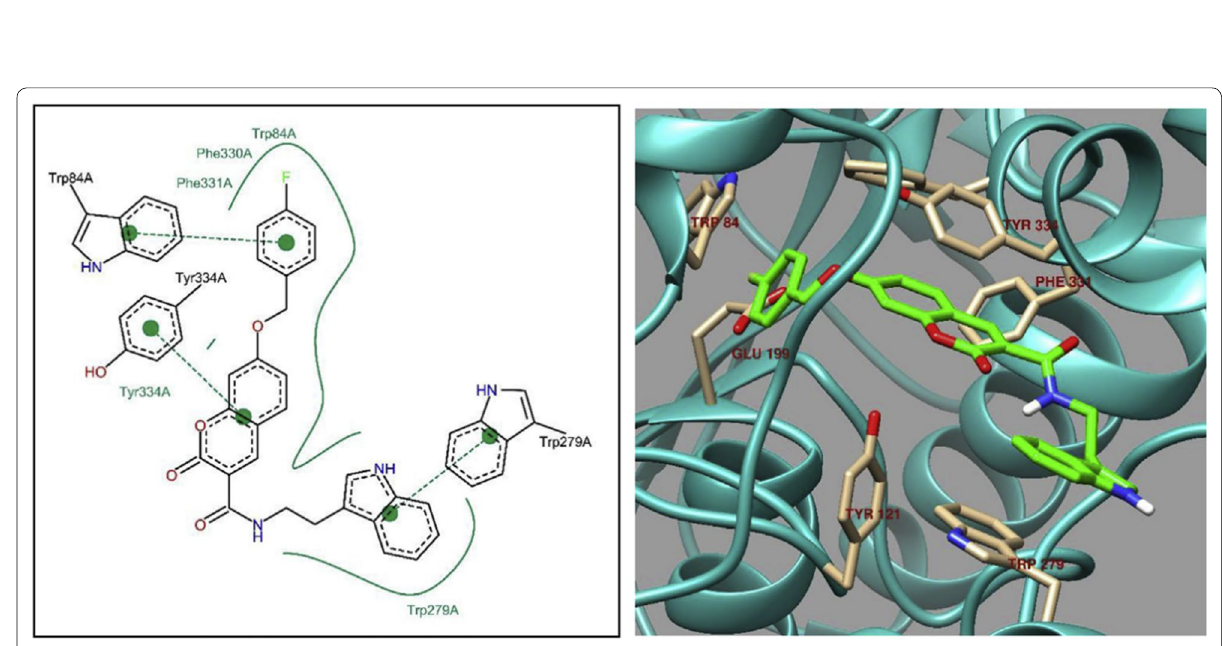
Fig. 45 2D (left) and 3D (right) representation of interactions of compound C44o in the active site of AChE